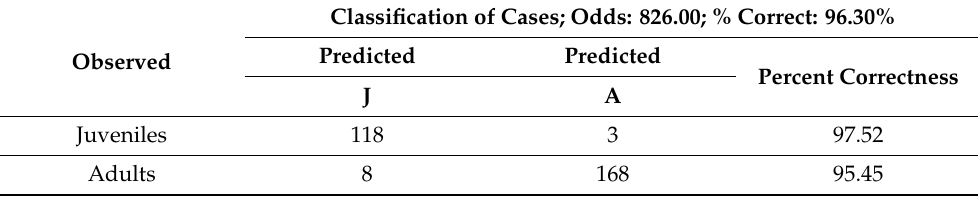
Table 5. Classification of cases in the logistic model in relation to dry lens weight. Classification of Cases; Odds: 826.00; % Correct: 96.30% Observed